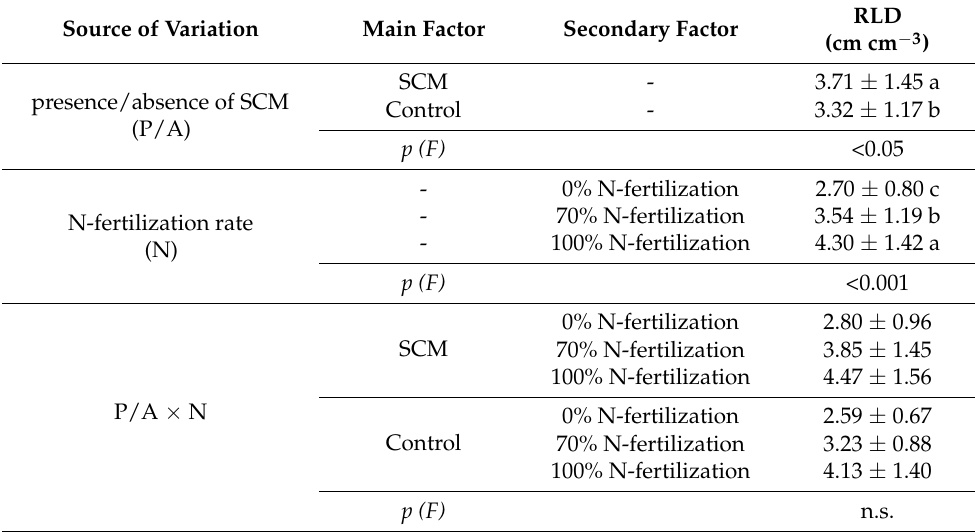
Table 2. Root Length Density (RLD; cm cm − 3 ) as affected by presence/absence of SCM (SCM vs control) and N-fertilization rate (0%, 70%, and 100% N-fertilization). Different letters within the same source of variation indicate statistical significant differences between means.